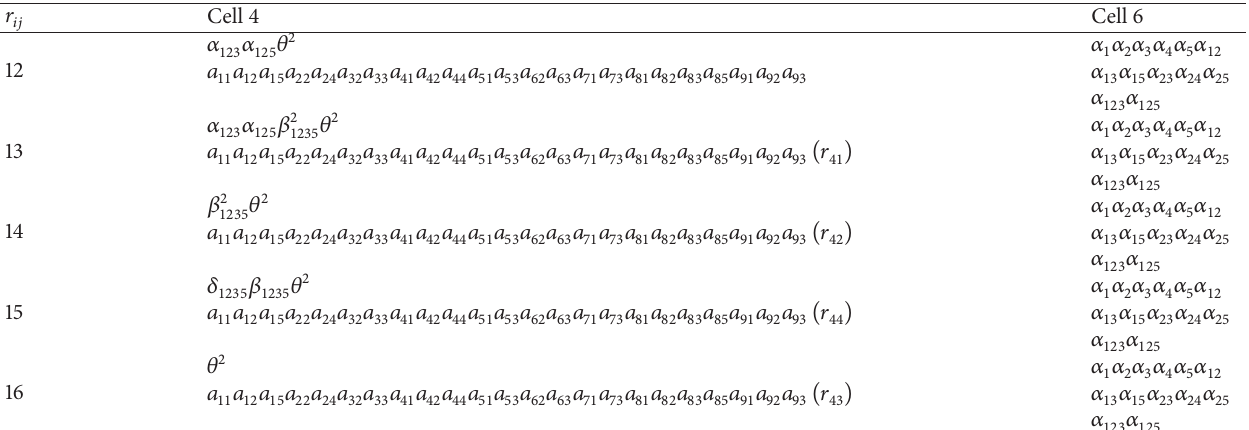
Table 6: Generation of frequent 4-itemsets.